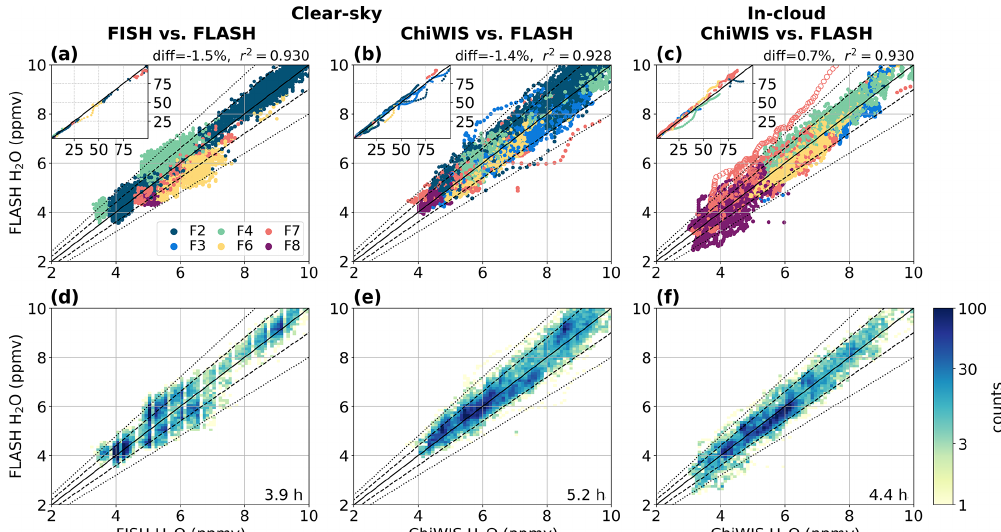
Figure 3. H 2 O vapor correlations between the three in situ hygrometers in the stratospheric range of 2–10ppmv: (a) clear-sky FISH vs. clear-sky FLASH, (b) clear-sky ChiWIS vs. clear-sky FLASH, and (c) in-cloud ChiWIS vs. in-cloud FLASH. Insets show a larger range from 2–100ppmv. Points are colored by flight number and plotted in random order. The open circles in panel (c) on F7 mark the time period of disagreement between ChiWIS and FLASH as the airplane was ascending out of a deep dive. Panels (d) – (f) show the same information as (a) – (c) but as the frequency of observations over all the flights in each 0.1ppmv by 0.1ppmv bin. The total hours of paired observations (for H 2 O < 10ppmv) are shown in the bottom right corner. The one-to-one line is plotted in solid black with ± 10% and ± 20% shown in dashed and dotted lines. The percentage difference and r 2 coefficients are shown above each panel. Table 3. Summary of measurement differences between instrument pairs for UTLS conditions ( < 10ppmv). Mean percentage differences ( (cid:49) ) and standard deviations ( σ (cid:49) ) between simultaneous measurements for each pair are given for each flight individually, the two periods of the campaign, and the campaign in total. ChiWIS and FLASH comparisons are further broken in clear-sky, cloudy, and all periods. F2 F3 F4 F6 F7 F8 Warm–wet Cold–dry All FISH vs. FLASH